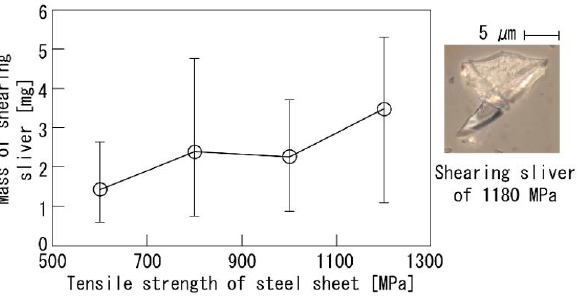
Figure 12. Effect of tensile strength of the steel sheet on the mass of shearing slivers.